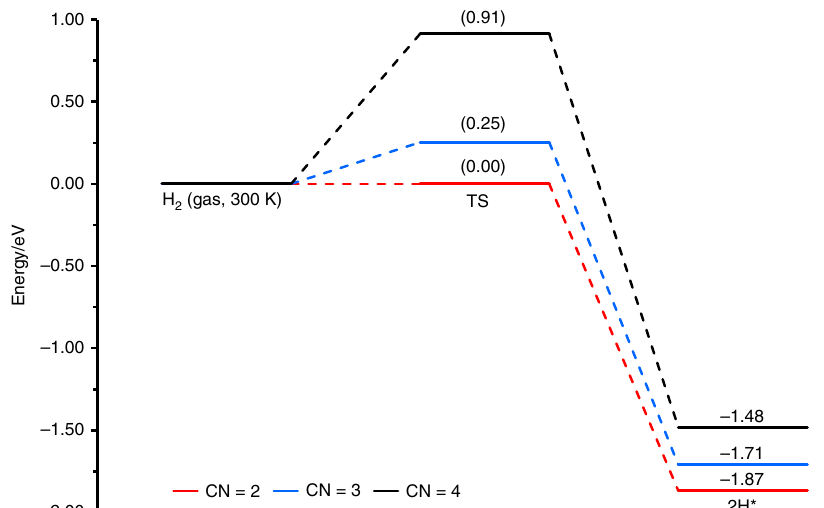
Fig. 5 Energy pro fi les of H 2 dissociation on Pt 1 /Fe 2 O 3 -T catalysts at 300 K. Four-coordinated Pt 1 /Fe 2 O 3 -500 (black line), three-coordinated Pt 1 /Fe 2 O 3 -550 (blue line), and two-coordinated Pt 1 /Fe 2 O 3 -600 (red line)